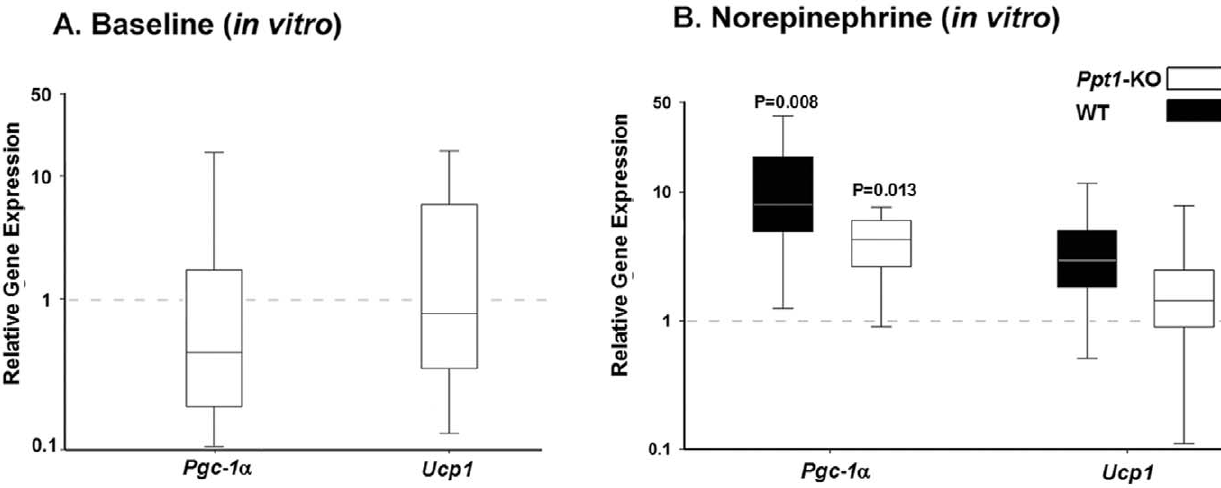
Figure 4. Brown adipose tissue response to norepinephrine in Ppt1- KO and wild-type mice. Brown adipose tissue explants from Ppt1 -KO and wild-type animals were maintained in similar conditions for 3 days and subsequently exposed to 100 nM of norepinephrine for 3 hours. A. Baseline relative Pgc1 a and Ucp1 gene expressions in brown adipose tissue explants from Ppt1- KO mice and wild-type controls (calibrator). The expression values in brown adipose tissue of wild-type controls were arbitrarily set to one for each gene examined and are indicated by the dashed horizontal line. B. Relative Pgc1 a and Ucp1 gene expressions in Ppt1- KO mice and wild-type controls after a three-hour exposure to 100 nM of norepinephrine compared with respective baseline expressions. The expression values in brown adipose tissue of Ppt1- KO and wild-type mice before norepinephrine were arbitrarily set to one for each gene examined and are indicated by the dashed horizontal line. Relative gene expressions were calculated using REST (cid:2) version 2009 [25]. In all panels, N=5 2 6 for each group.